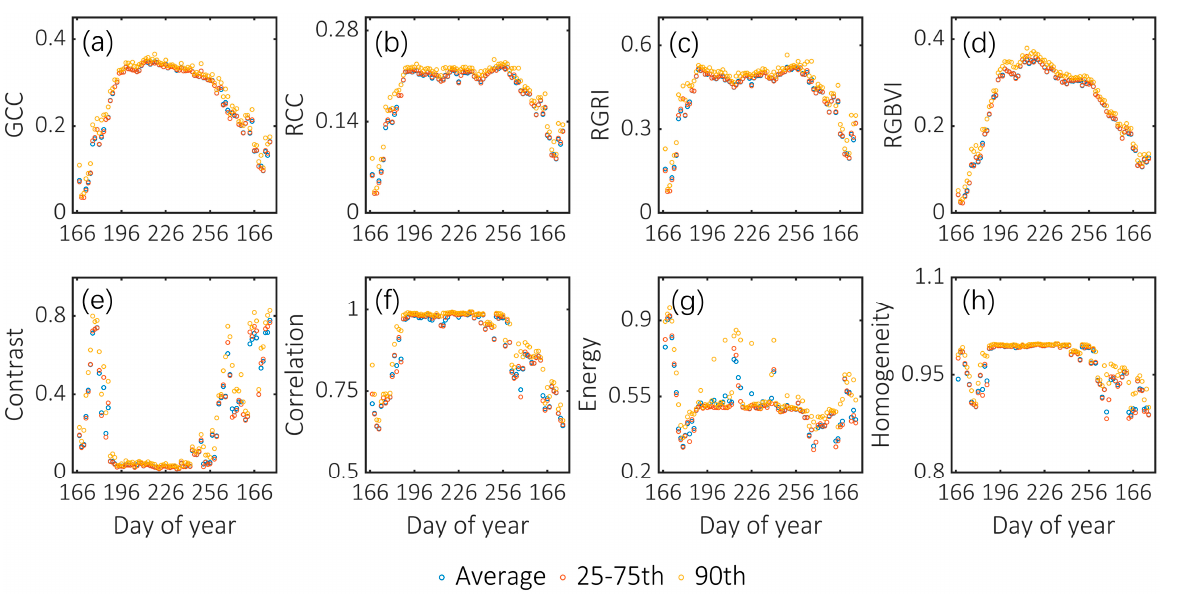
Figure 3. The average values, average values between the 25th and 75th percentiles and average of the 90th percentile of spectral and textural indices of each day. Note: the presented temporal changes in spectral indices are based on phenocam data obtained at Shangqiu in 2018. Note: ( a – h ) each represented indices calculated using GCC, RCC, RGRI, RGBVI, Contrast, Correlation, Energy, and Homogeneity, respectively.